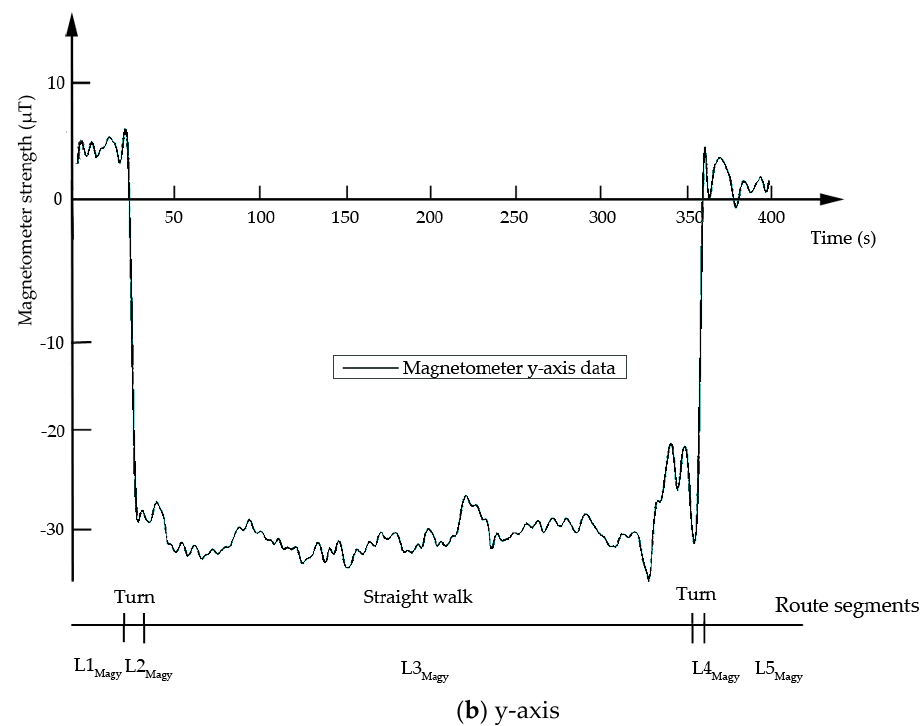
Figure 2. Magnetometer data resolved along the x-axis ( a ) and y-axis ( b ).